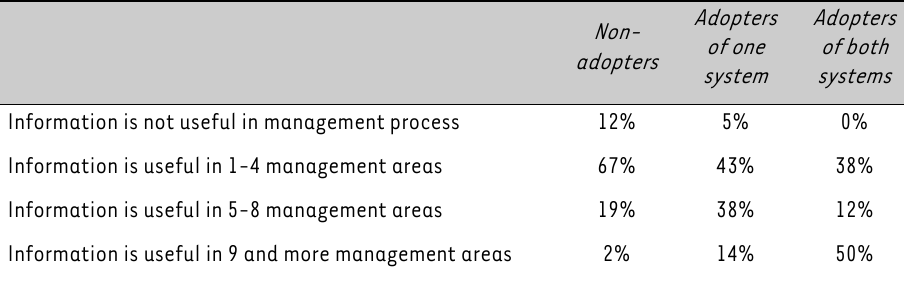
TABLE 5: Availability of information in management areas*